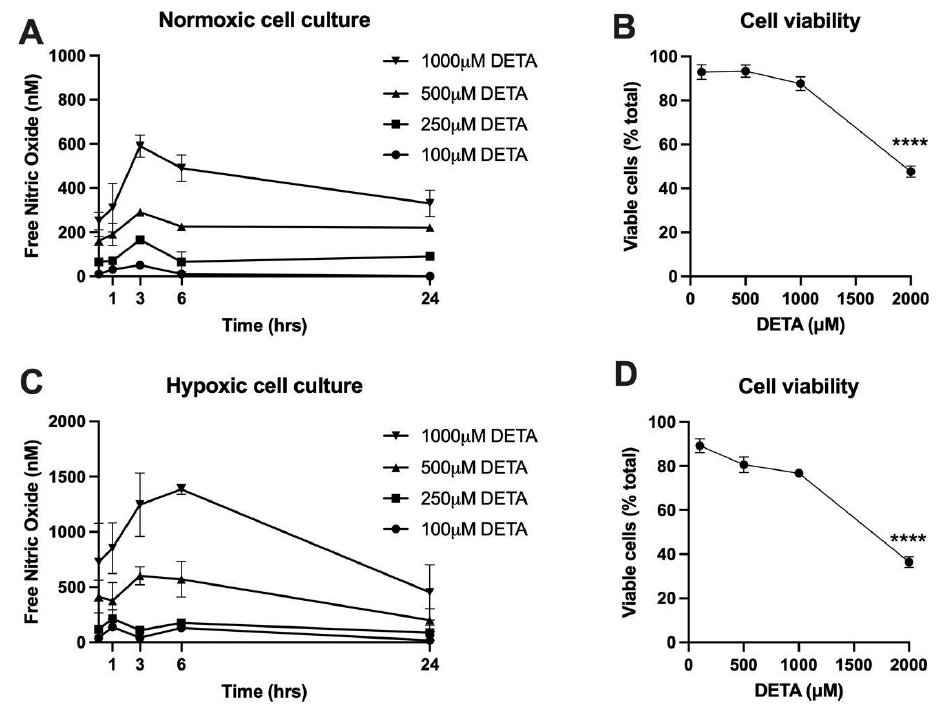
Figure 1. Nitric Oxide (NO) concentrations and cell viability over 24 h study period. ( A ) NO production from different concentrations of DETA in normoxic cell culture of syncytialized BeWo cells. ( B ) BeWo cell viability in response to increasing DETA concentrations under normoxia. ( C ) NO production from different concentrations of DETA in hypoxic (2% O 2 ) cell culture of syncytialized BeWo cells. ( D ) BeWo cell viability in response to increasing DETA concentrations under hypoxia, mean ± SD, **** p < 0.0001 compared to no DETA.